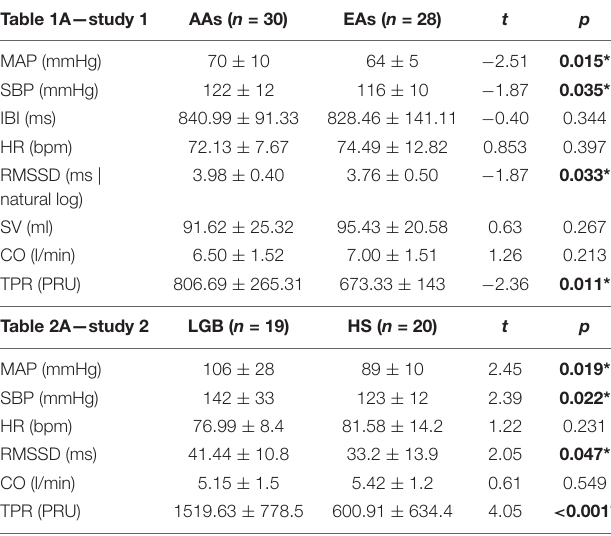
TABLE 1 | Mean and standard deviations of resting cardiovascular and hemodynamic parameters in African Americans (AAs) compared to European Americans (EAs) (study 1) and in Lesbian, Gay and Bisexuals (LGB) compared to heterosexual (HS) participants (study